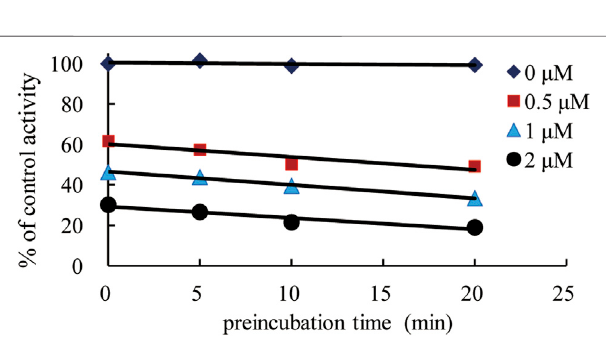
FIGURE 5 | Time-dependent inhibition of CYP3A4 by